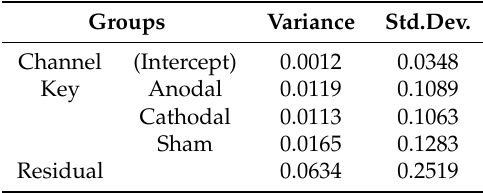
Table 2. Mixed model—Random effects estimations.